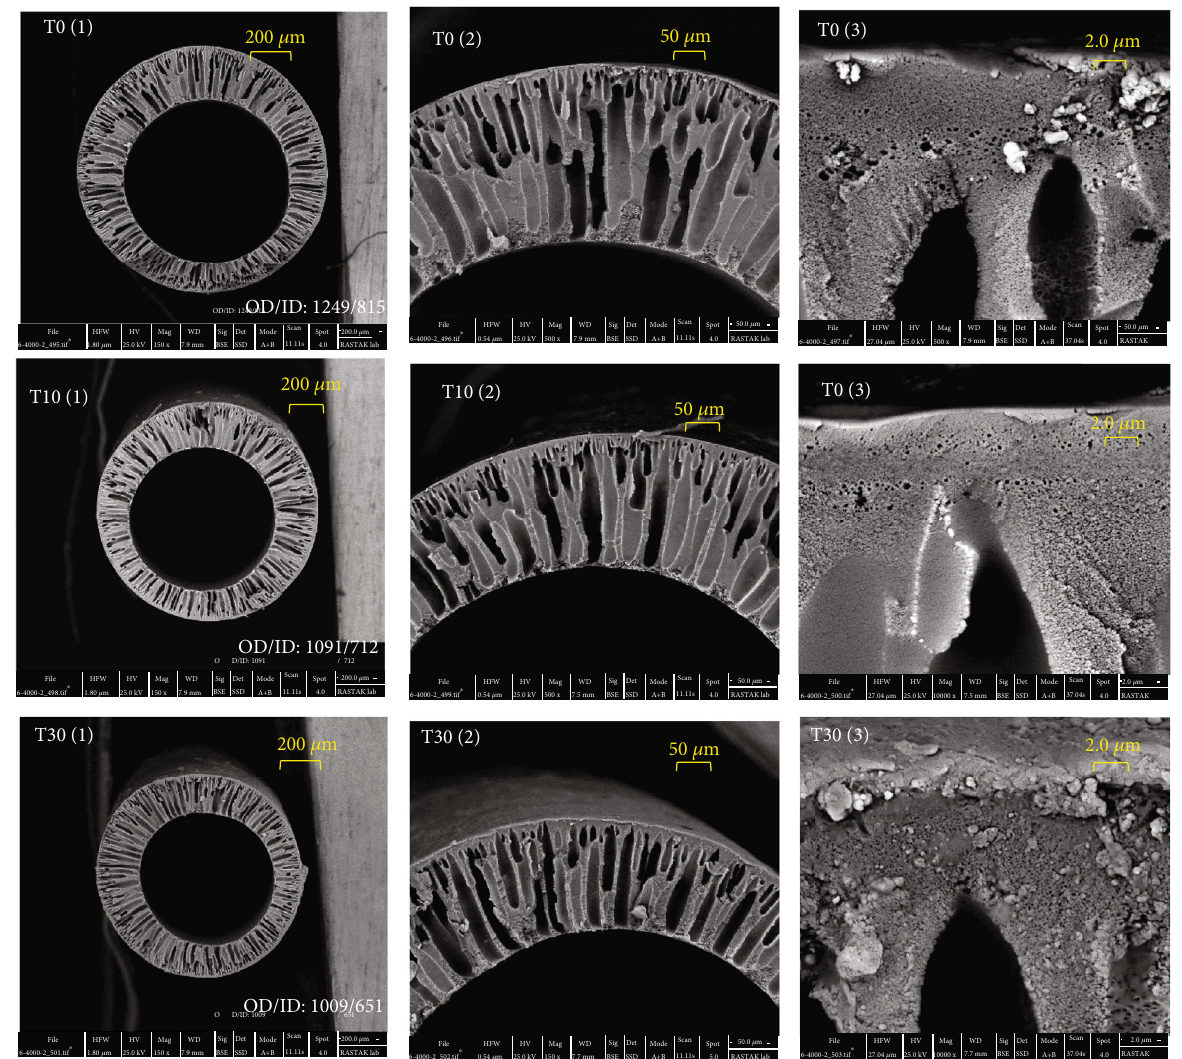
Figure 12: E ff ect of take-up speed on cross sectional morphologies of PAN hollow fi bers: (a) 150x magni fi cation; (b) 500x magni fi cation; (c) 10000x magni fi cation (T0: free fall; T10: 10% stretch; T20: 20%